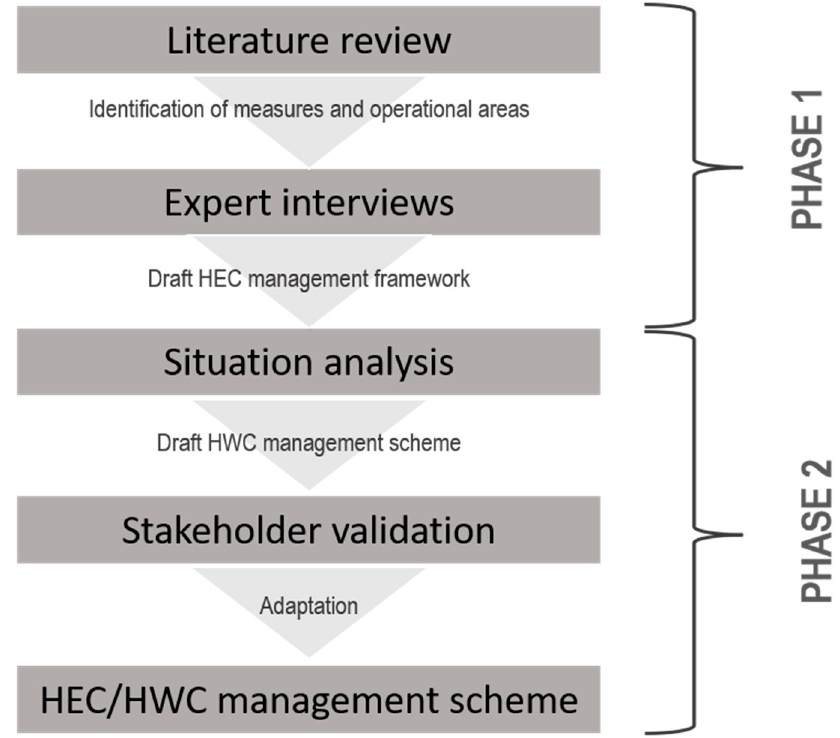
Figure 1. Overview of phase 1 and phase 2 of the study process for the development of an integrated and holistic HEC/HWC management framework.